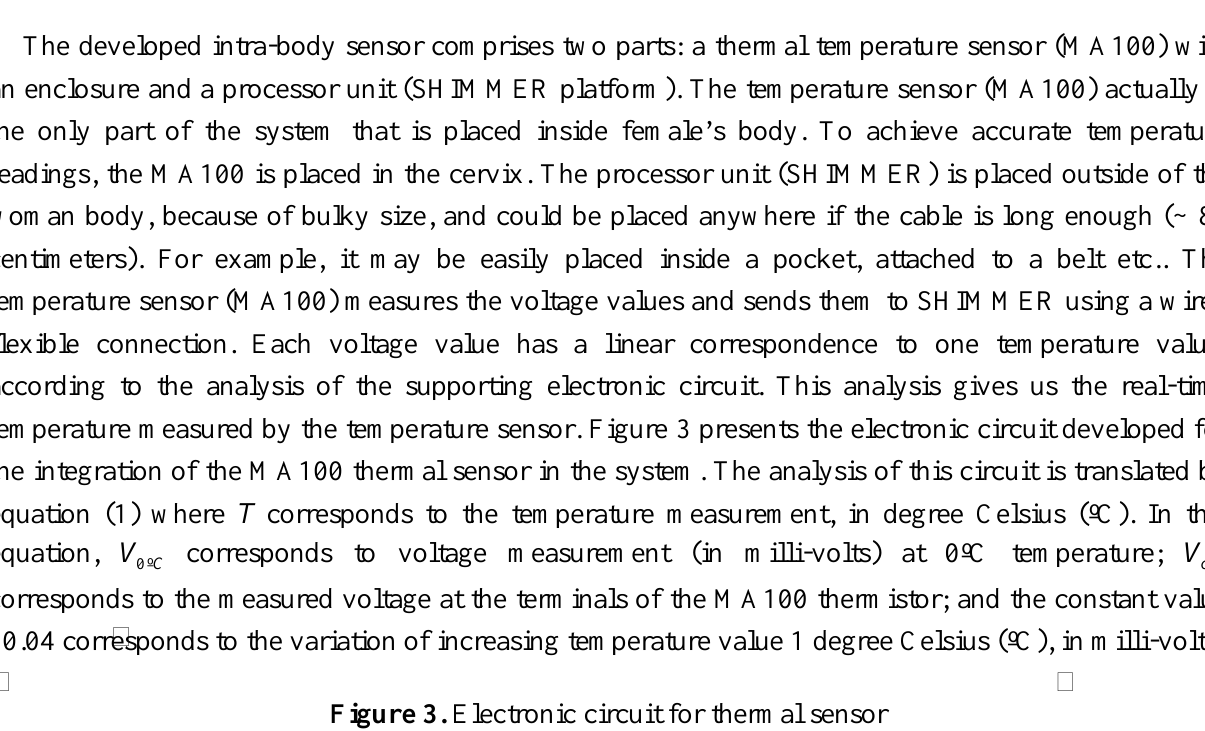
Figure 3. Electronic circuit for thermal